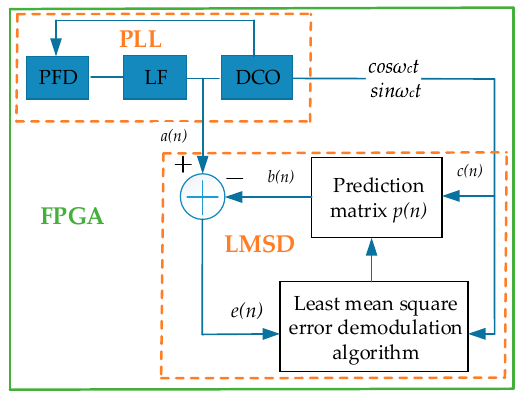
Figure 8. Diagram of least mean square demodulation.